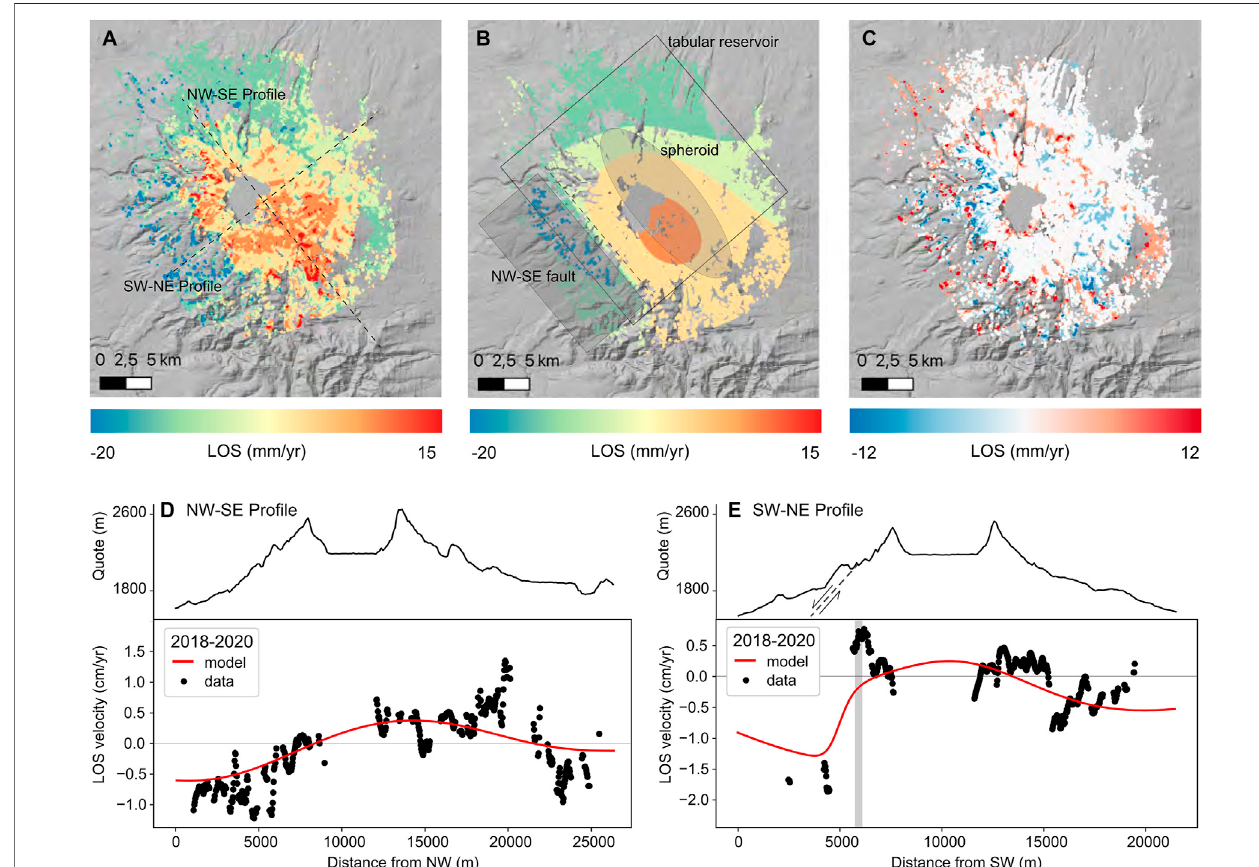
FIGURE3| Comparisonbetween (A) InSARALOS-2dataand (B) LOSdisplacementsgeneratedbythemeanmodelobtainedbynon-linearinversion.Thesurface projection of the spheroid, the tabular reservoir and the NW-SE fault are also reported in shaded grey. Residuals, i.e. difference between observed data ( Figure 2 ) and modelled data are reported in (C, D) NW-SE and (E) SW-NE pro fi les as reported in Figure 2 , with LOS data from ALOS-2 (black dots) and model (red line). The grey vertical bar is the approximate location of the NW-SE trending fault trace located in the western fl ank of the volcano. On the top is reported the topographic relief along the pro fi les. The dashed line is the NW-SE fault seen in a section across the volcano edi fi ce.